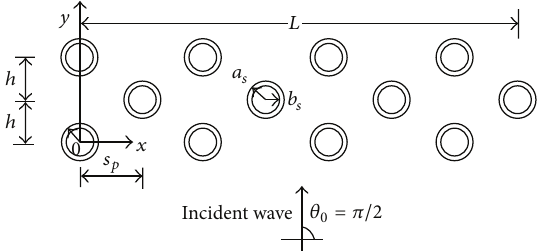
Figure11:Thereferencesystemandanalysismodelofincidentplane waves scattering by multirows of piles (hexagon arrangement, 𝑁 = 12